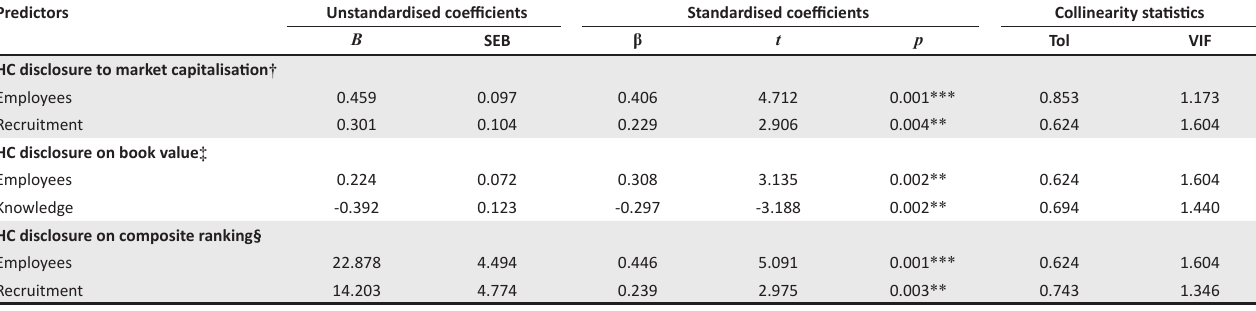
TABLE 5: Multiple regression of human capital and organisational performance ( N = 150). Predictors